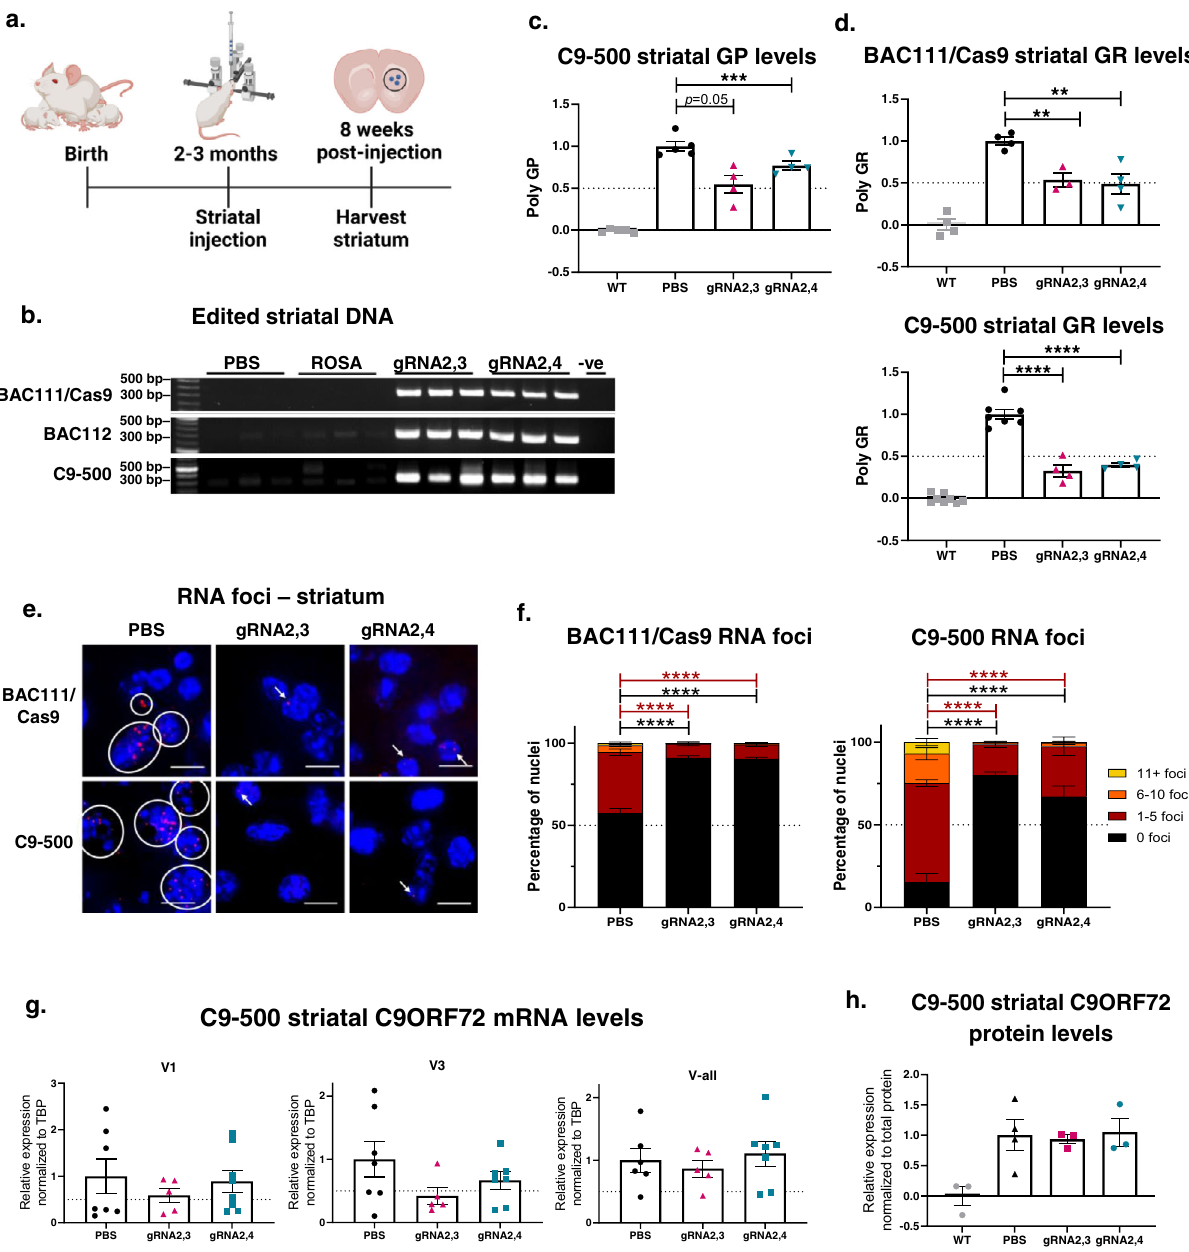
Fig.3|InvivogeneeditingresultsinadecreaseofRNAfociandpoly-dipeptides in different C9BAC-transgenic mouse models. a Schematic of treatment and harvest of AAV9-delivered Cas9 and gRNA treatment of different C9ORF72 BAC- transgenic mouse models. Mice were treated at 2 – 4 months of age with bilateral striatal injections, and the striatums were harvested 8 weeks after treatment for further analyses. BAC111, BAC112, and C9-500 mice were treated with both AAV9 – SpCas9 and AAV9-gRNA2,3 or AAV9-gRNA2,4 and BAC111/Cas9 mice with only AAV9-gRNA2,3 or AAV9-gRNA2,4. b Genomic DNA of treated BAC111/Cas9, BAC112, and C9-500 mouse striatums was ampli fi ed with primers fl anking gRNA seedsequences,andPCRproductswereresolvedbyelectrophoresis.Theexpected band for gRNA2,3- and gRNA2,4-edited DNA is 680bps. No band is expected for unedited DNA. AAV9-Rosa treatment and PBS treatment were used as a control. Genomic DNA was ampli fi ed with primers fl anking gRNA seedsequences, and PCR products resolved by electrophoresis. The expected band for gRNA2,3- and 2,4- edited DNA is 680bps. No band is expected for unedited DNA. c Relative expres- sion of poly-GP in the striatums of treated C9-500 mice. Data represent mean± SEM,WTandPBS n =5,treatedgroups n =4,one-wayANOVA,Dunnett, P =0.0502, *** P =0.0004. d Relative expression of poly-GR in the striatums of treated BAC111/ Cas9 and C9-500 mice. Data represent mean±SEM, BAC111/Cas9 WT,